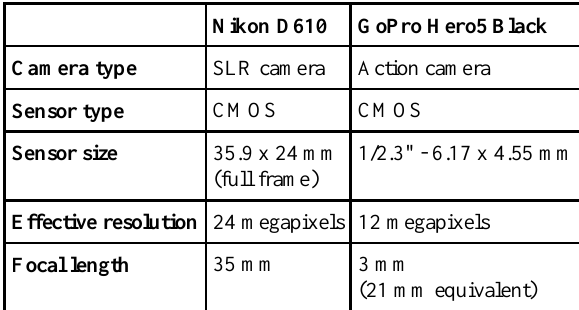
Table 2. Technical specifications of the